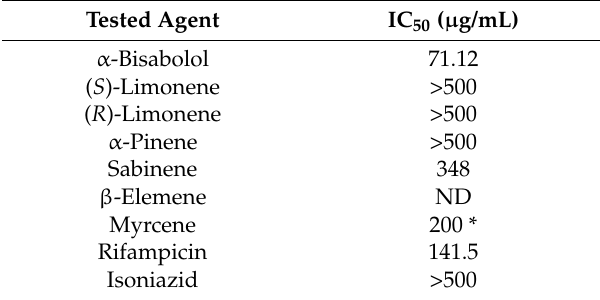
Table 6. Cytoxicity of tested terpenes and